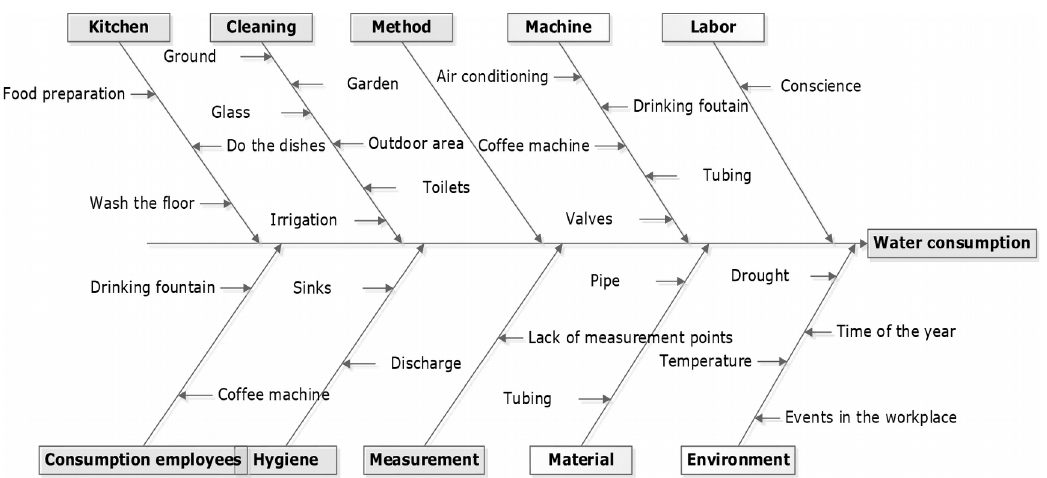
Figure 9. Ishikawa diagram for reducing water consumption by